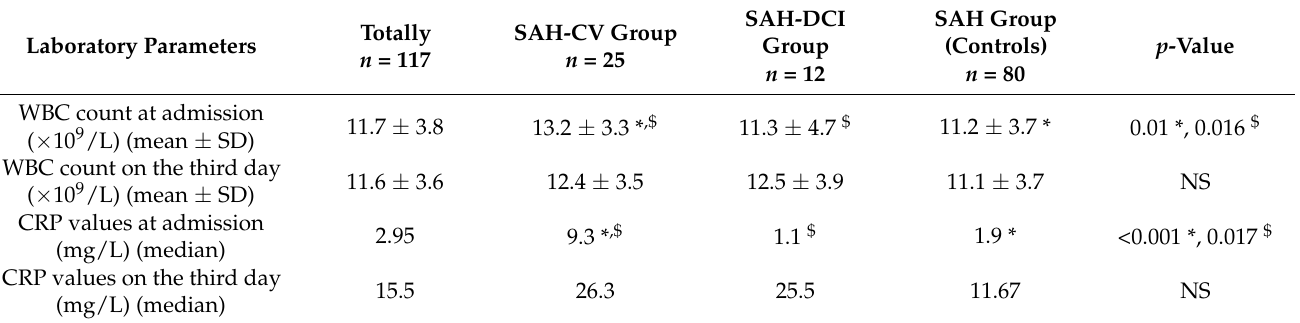
Table 2. WBC count and CRP values at admission and on the third day between the three